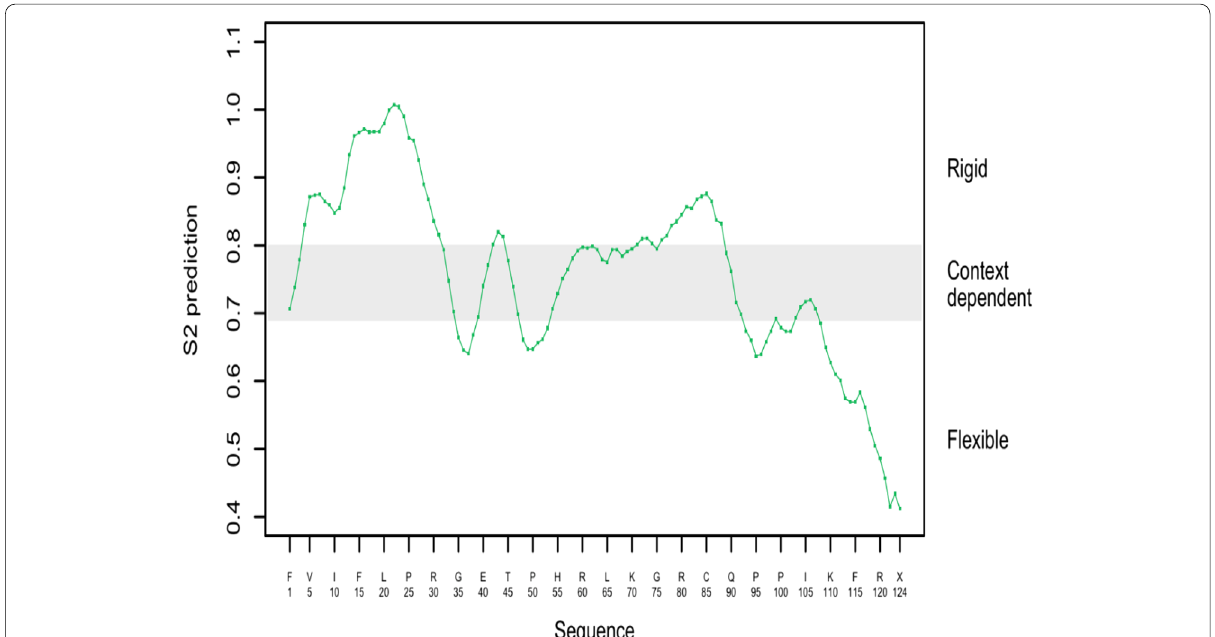
Fig. 7 Prediction of dynamic nature of AmCoc protein using DynaMine server: our results showed that the most of regions of AmCoc are rigid, and there are only nine flexible regions with the lowest predicted S2 value which are Phe115 (0.57), Arg116 (0.58, Pro117 (0.56), Pro118 (0.53), Pro119 (0.51), Gly121 (0.46), Trp122 (0.41), and Thr123 (0.43)